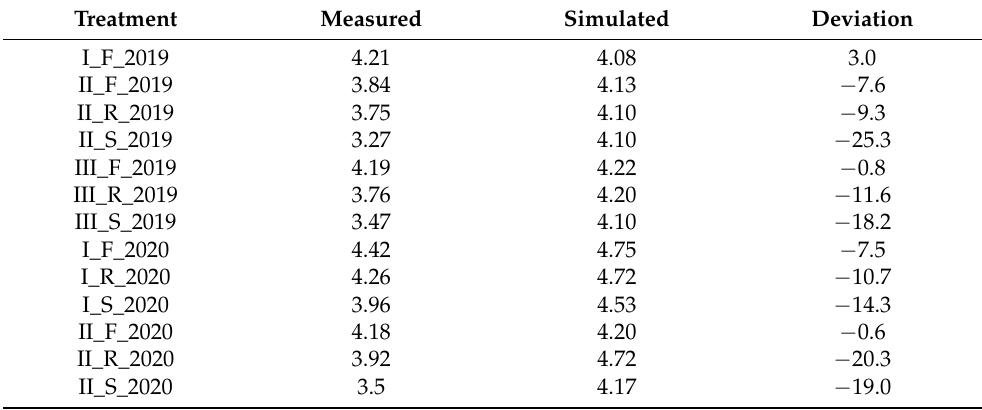
Table 8. Measured and simulated yields (Mg ha − 1 ) based on modeled irrigation depths; full (F) and deficit (R and S) irrigation treatments and sowing periods I (spring), II (late spring), and III (summer). Treatment